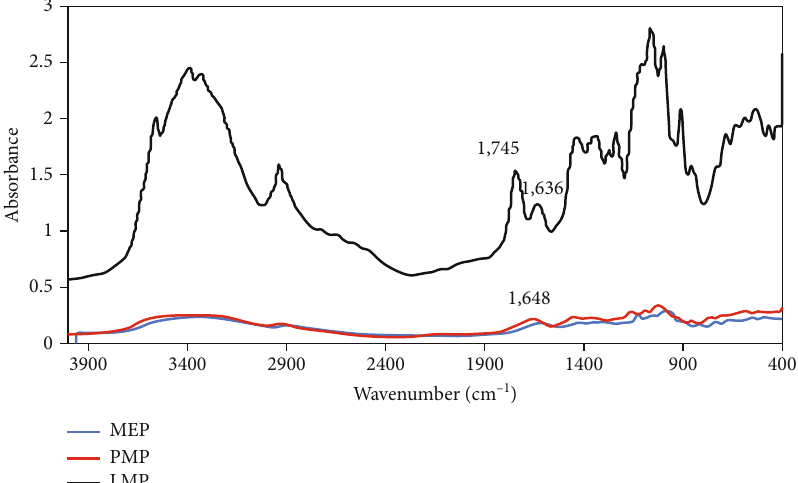
Figure 2: FTIR spectra of di ff erent pectin (MEP: microwave-extracted pectin; PMP: puri fi ed MEP; LMP: commercial low-methoxy pectin).